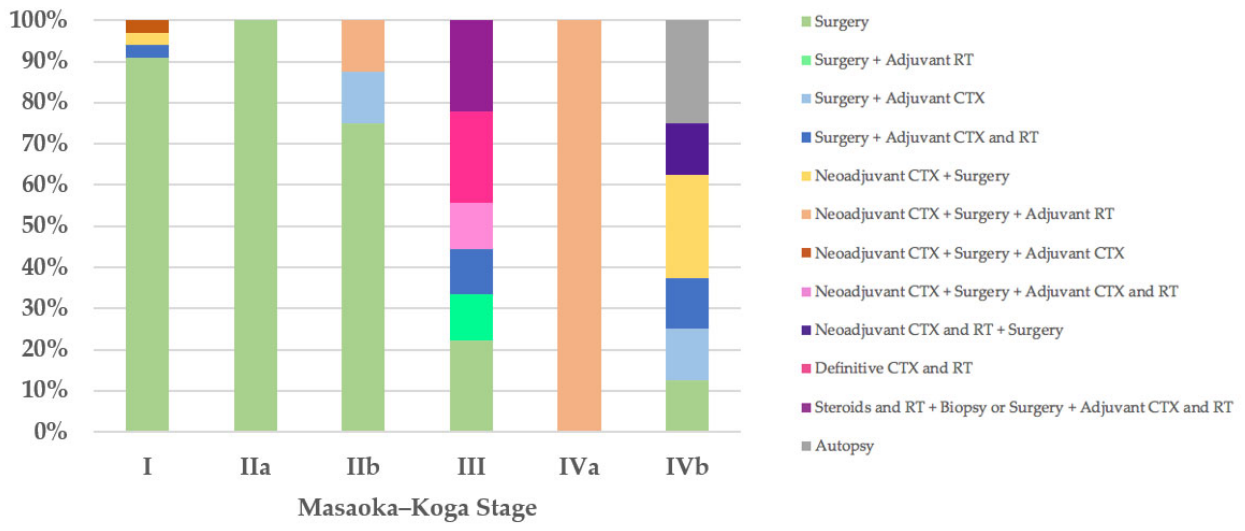
Figure 3. Treatment according to Masaoka–Koga stage. CTX, chemotherapy; RT,